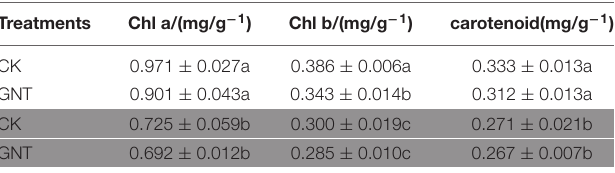
TABLE 2 | Chlorophyll content of GNT treatments under dark and light conditions: Chla (chlorophyll a), Chlb (chlorophyll b). Treatments